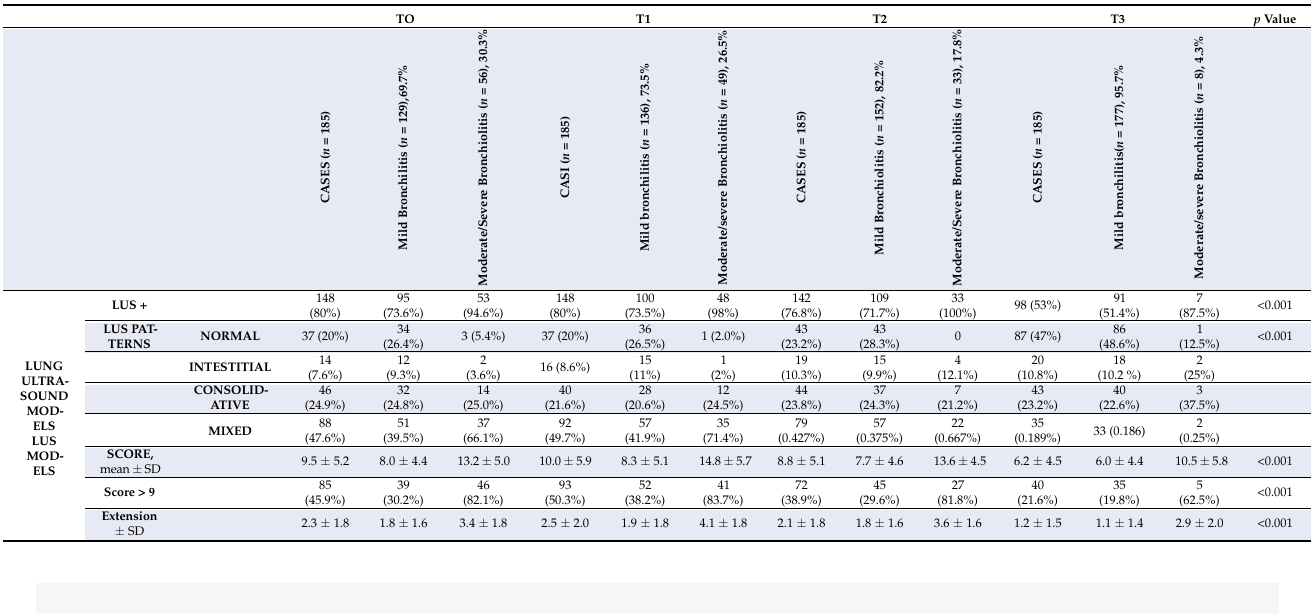
Table 6. Changes in lung ultrasound (LUS) models during the different subsequent controls (T0, T1, T2 and T3), and changes in treatments offered. HFNC: high flow nasal cannulae. nCPAP: nasal Continuous Positive Airway Pressure.